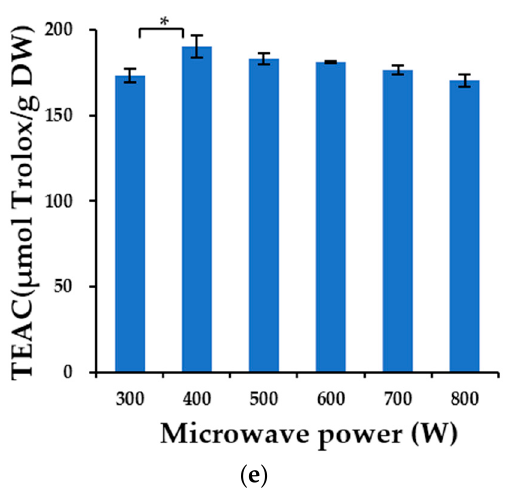
Figure 2. Effects of ethanol concentration ( a ); solvent/material ratio ( b ); extraction time ( c ); extraction temperature ( d ); and microwave power ( e ) on the extraction efficacy. Note: * Significant difference ( p < 0.05).